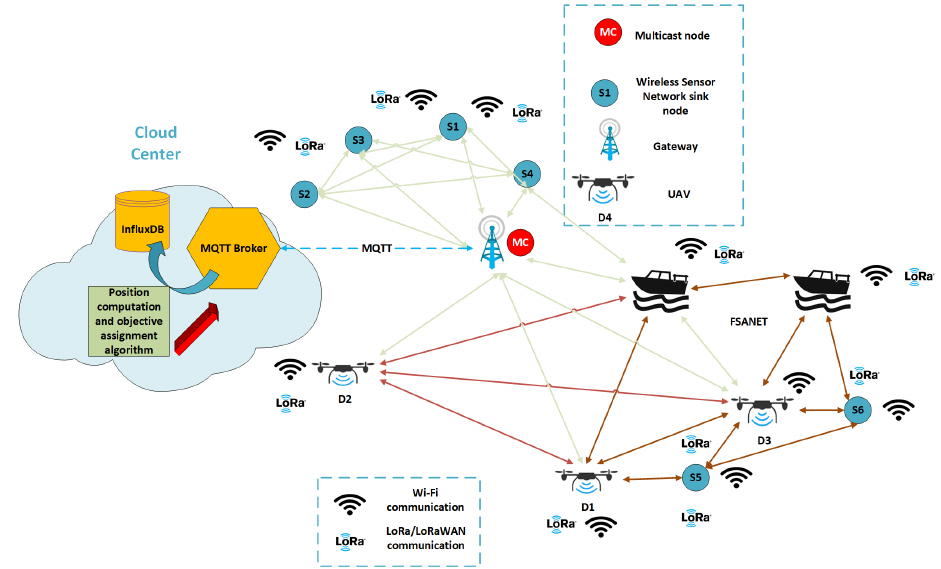
Figure 1. FSANET-WSN (Flying and Surface Ad Hoc NETwork serving Wireless Sensors Networks)